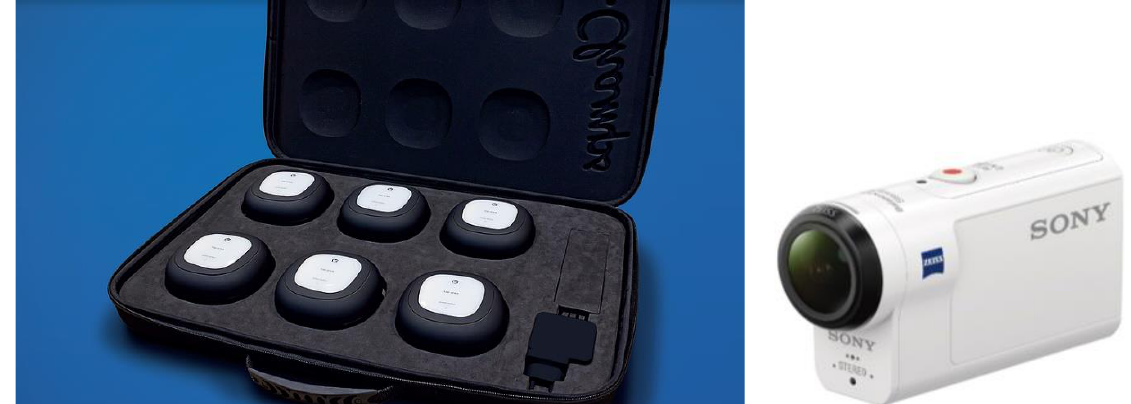
Figure 1. ( left ) ROXs Pro System© with the charging and storage case for mobility. A tablet PC or mobile phone (IOS or Android) is needed to control the ROXs Pro System© settings and show the output data. ( right ) Sony Action camera to record movements.